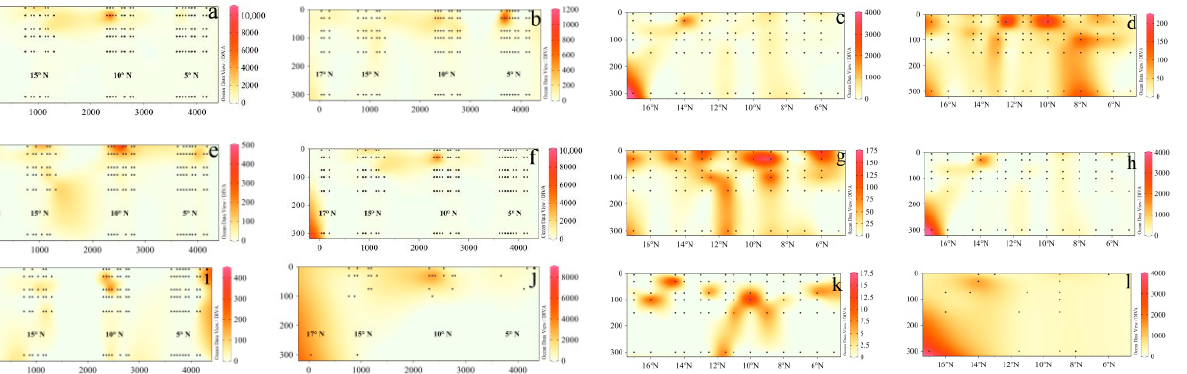
Figure 5. Vertical distribution of phytoplankton (cells L − 1 ). ( a , c ) Phytoplankton. ( b , d ) Diatom. ( e , g ) Dinoflagellates. ( f , h ) Cyanobacteria. ( i , k ) Ochrophyta. ( j , l ) Trichodesmium spp .